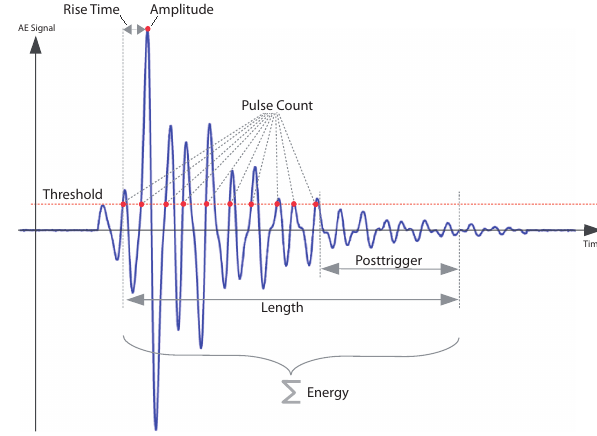
Fig. 1. Extracted parameters from an AE